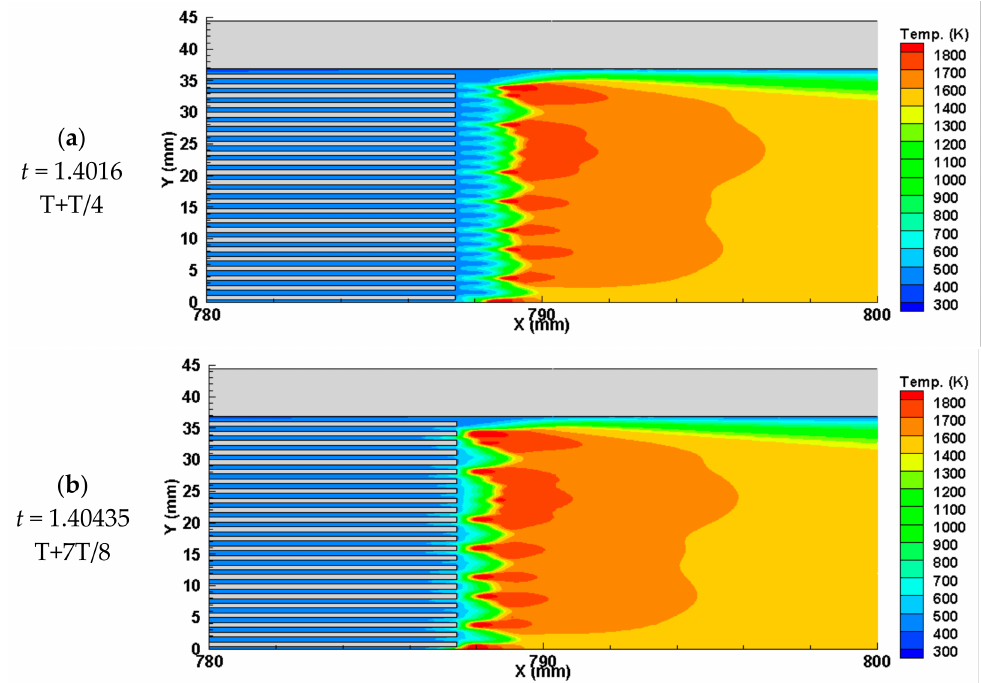
Figure 15. Temperature distribution at different